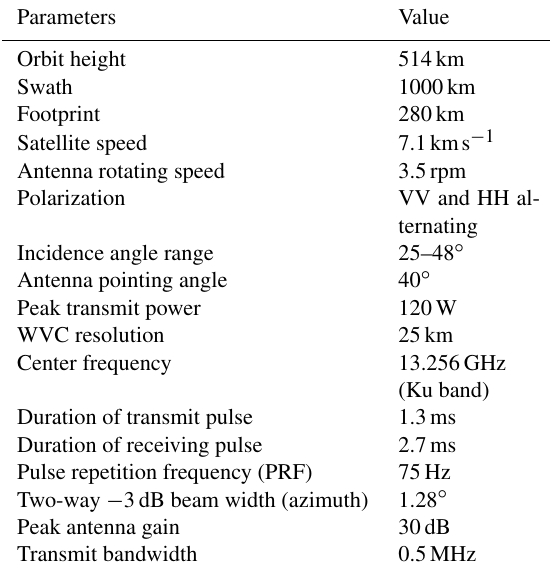
Table 1. Main parameters of CFOSAT SCAT.